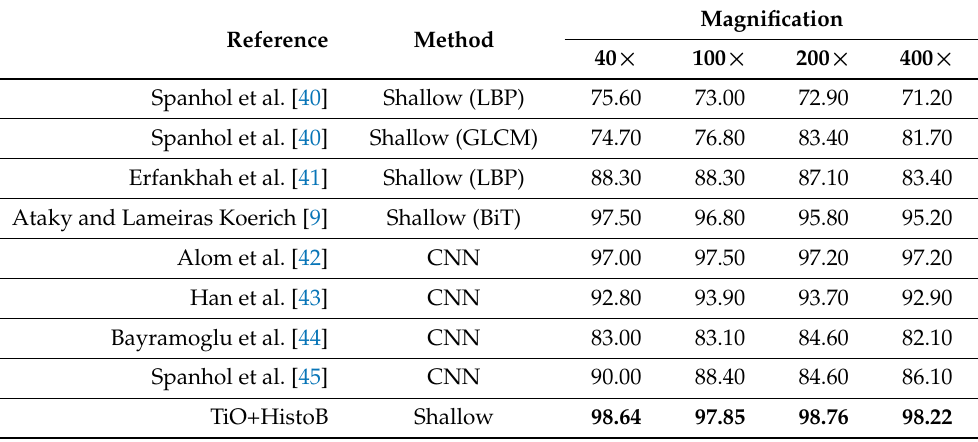
Table 9. Accuracy (%) of shallow and deep approaches on the BreakHis dataset. All works used the same data partitions for training and testing. The best result for each magnification is shown in